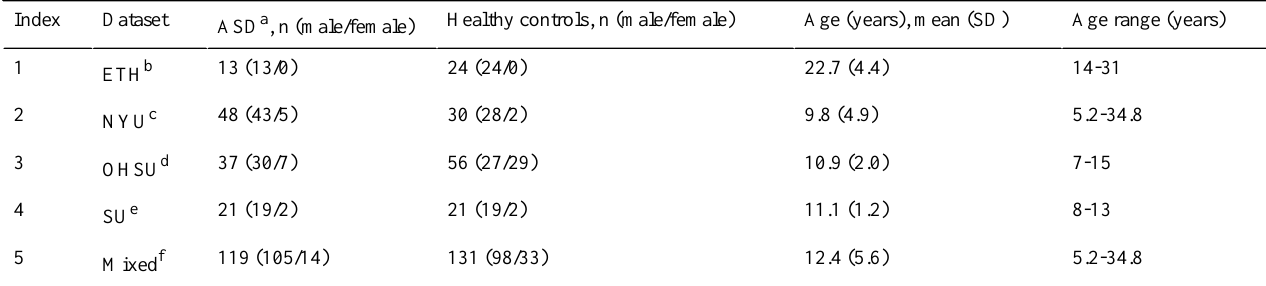
Table 1. Overview of participants in the 4 training